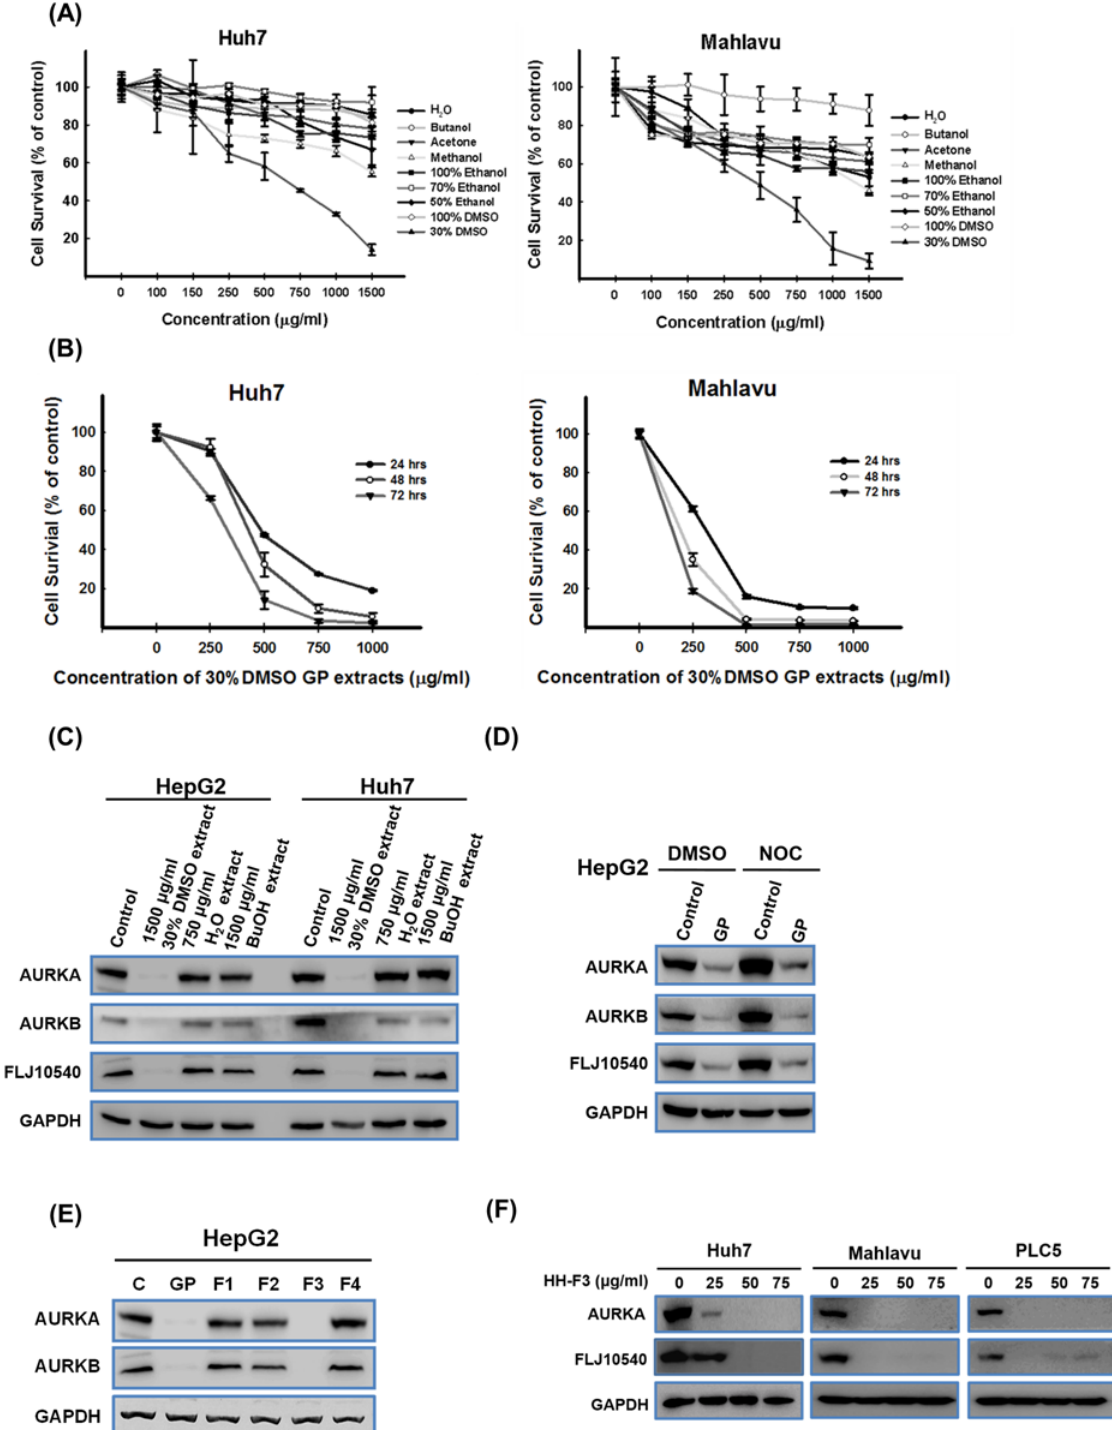
Fig 1. GP extracts and their fractions regulate oncogenic protein expression in HCC cell lines. Huh7 and Mahlavu cells were treated with GP extracts prepared in water, butanol, acetone, methanol, 100% ethanol, 70% ethanol, 50% ethanol, 100% DMSO, or 30% DMSO at concentrations of 100, 150, 250, 500, 750, 1000 and 1500 μ g/ml for 72 hrs. The viability of the treated cells was determined using MTT assays. The 30% DMSO GP extracts was associated with the greatest inhibition of growth of Huh7 and Mahlavu cells after 72 hrs. (B) Huh7 and Mahlavu cells were treated with concentrations of 0, 250, 500, 750 and 1000 μ g/ml of the 30% DMSO GP extracts for 24, 48, and 72 hrs, and MTT assays were conducted. The IC 50 concentrations of the 30% DMSO GP